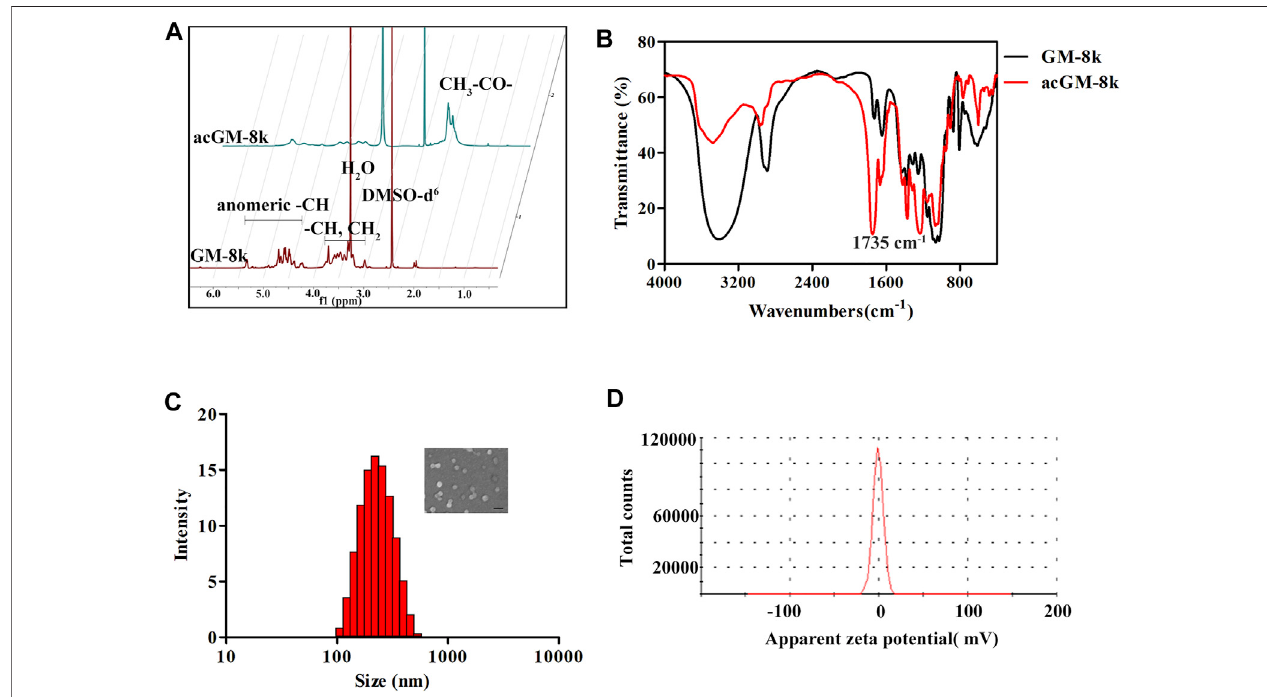
FIGURE3| CharacterizationofacGM-8kandacGM-8knanoparticles(NPs). (A) 600 MHz1D 1 H-NMRspectrumofGM-8kandacGM-8k. (B) Theinfraredspectra of GM-8k and acGM-8k. (C) Particle size distribution and morphology of acGM-8k NPs (inserted picture, scale bar: 200 nm). (D) Zeta potential of acGM-8k NPs.